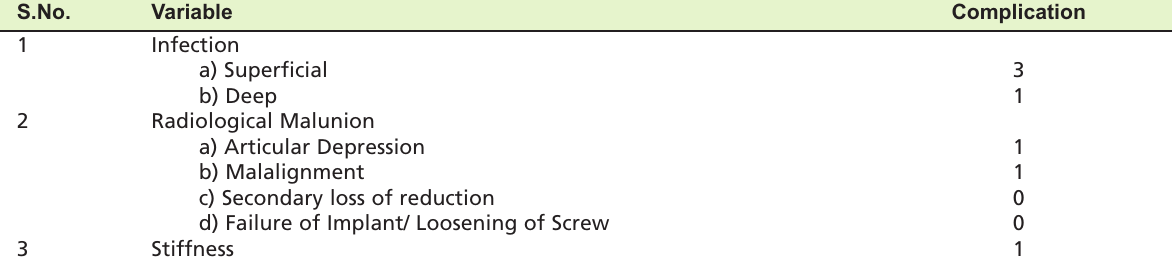
Post-operative Table IV: